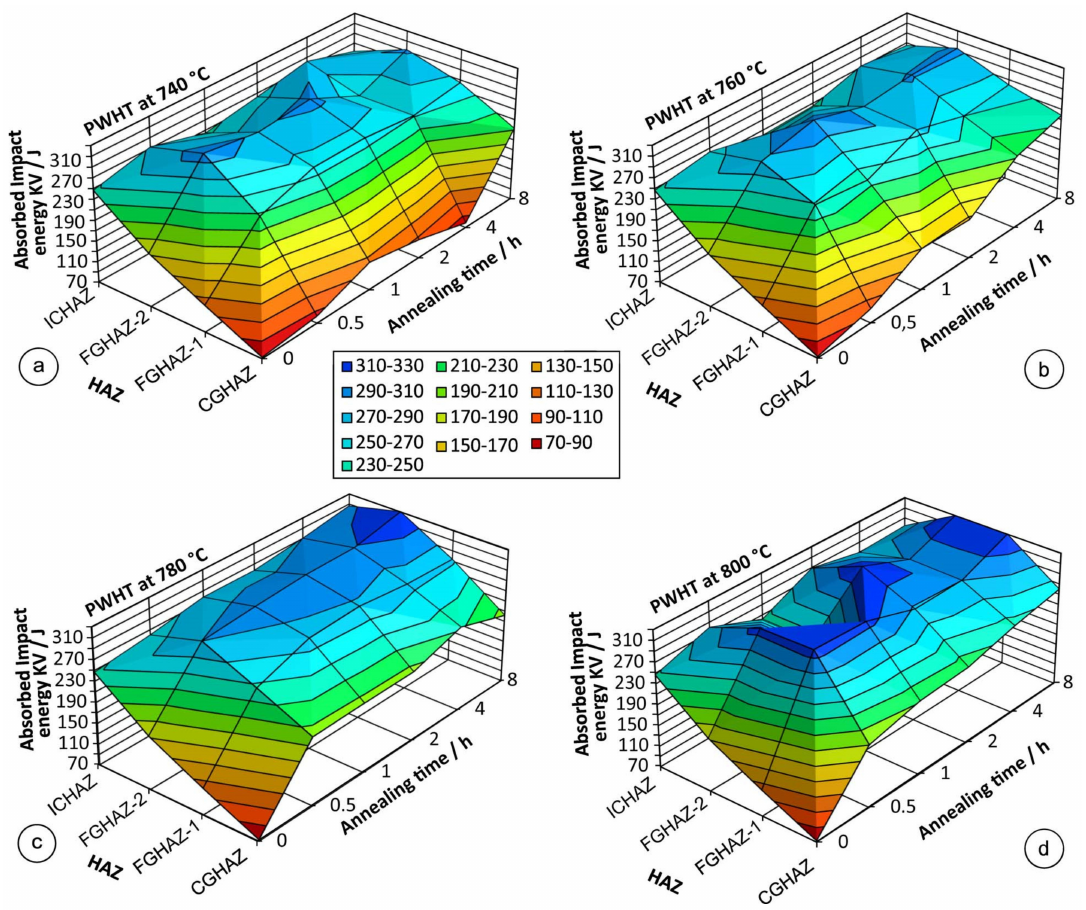
Figure 7. The total impact energies KV in individual HAZ subzones: ( a ) after PWHT at 740 ◦ C; ( b ) after PWHT at 760 ◦ C; ( c ) after PWHT at 780 ◦ C; ( d ) after PWHT at 800 ◦ C; Annealing time t = 0 denotes as-welded